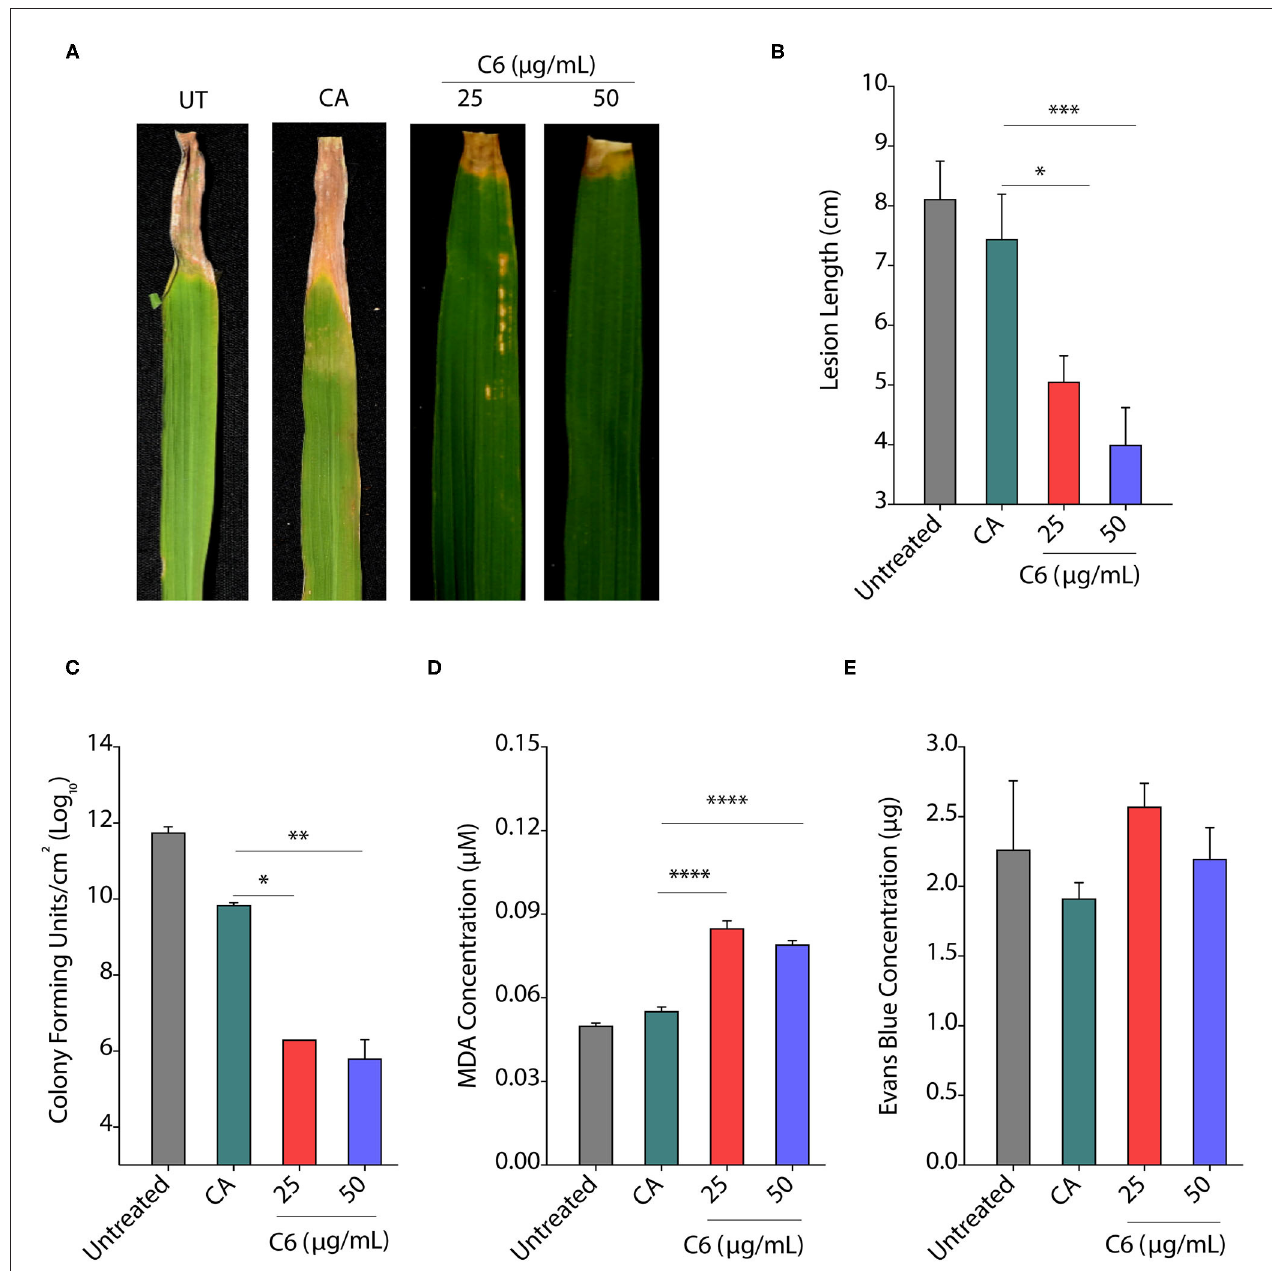
FIGURE 6 | Seed priming provides protection from infection. (A, B) Pictures showing the bacterial disease symptoms at 15 dpi (A) and change in lesion length at 30 dpi (B) after priming of rice seedlings with C6 CAGC. (C–E) Change in CFUs (C) , lipid peroxidation derived malondialdehyde (MDA) levels (D ) , and membrane stability assessment by Evan’s blue dye quantification (E) of infected leaves at 5 dpi after priming with C6 at 25 and 50 µ g/ml. For priming, rice seeds were soaked in C6 at 25 and 50 µ g/ml overnight followed by vacuum infiltration for 5min, and seedlings were established in the soil. About 30 day-old plants were infected with Xoo (10 6 cfu/ml). The experiment was repeated three times with minimum of 10 biological replicates. Values are means + SE from three biological replicates. A significant difference was determined by using two-way ANOVA with Tukey’s HSD test ( α = 0.05, * p < 0.05, ** p < 0.01, *** p < 0.001, **** p < 0.0001).